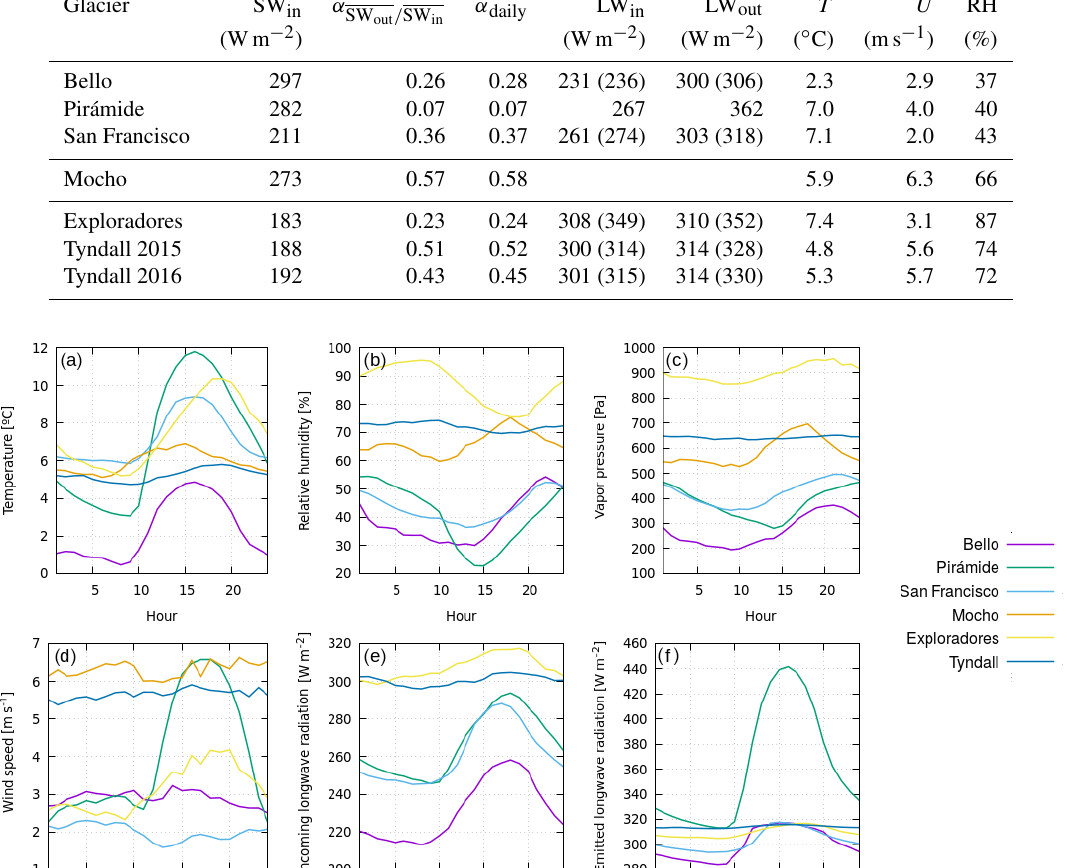
Table 4. Mean values of relevant meteorological and glacier surface data during the study periods. For the longwave radiative fluxes, the bias-corrected value is indicated as well as the originally measured one in parentheses.